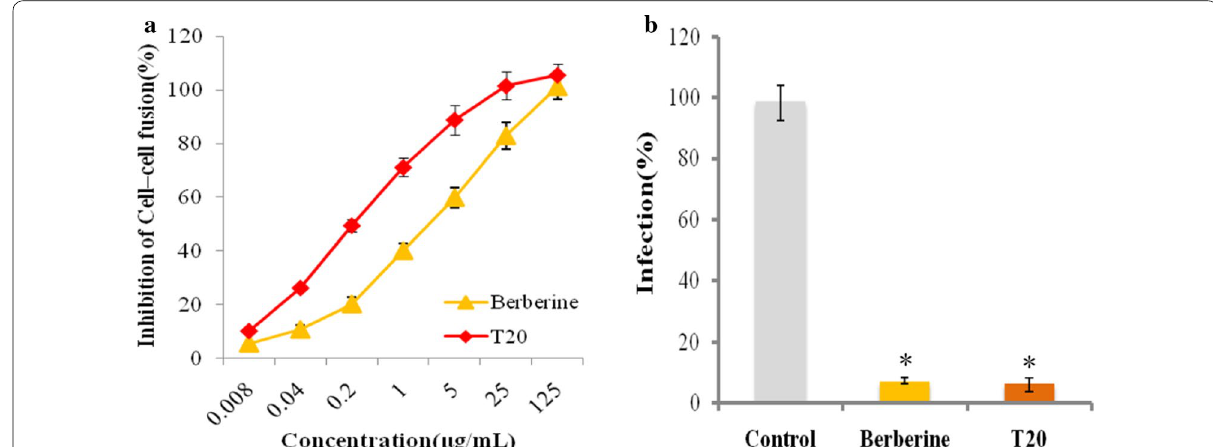
Fig. 5 The inhibitory effects of berberine on HIV-1 Env-mediated cell–cell fusion. a Inhibition of berberine on HIV-1 Env-mediated syncytium formation. T20 was used as the positive control. b Inhibition activity of berberine on HIV-1 infection. Target cells were infected with the HIV-1 virus in the presence or absence of berberine. PBS was used as the negative control